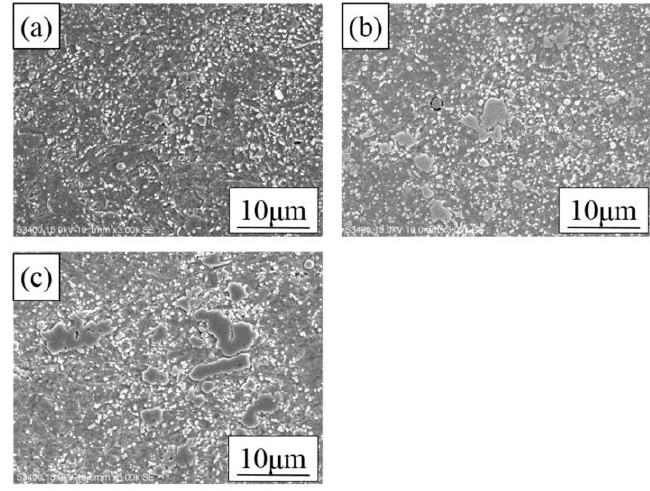
Figure 6. Microstructure of modified 440A MSS after ( a ) HT1; ( b ) HT2 and ( c ) HT3 processes.